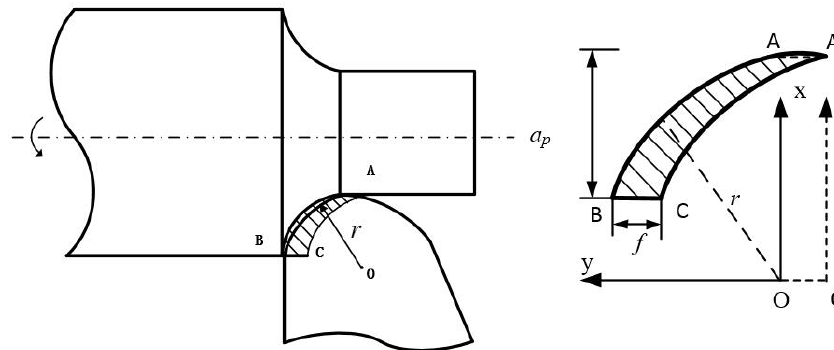
Figure 2. Tool-Workpiece Contact Zone with Corner Radius.